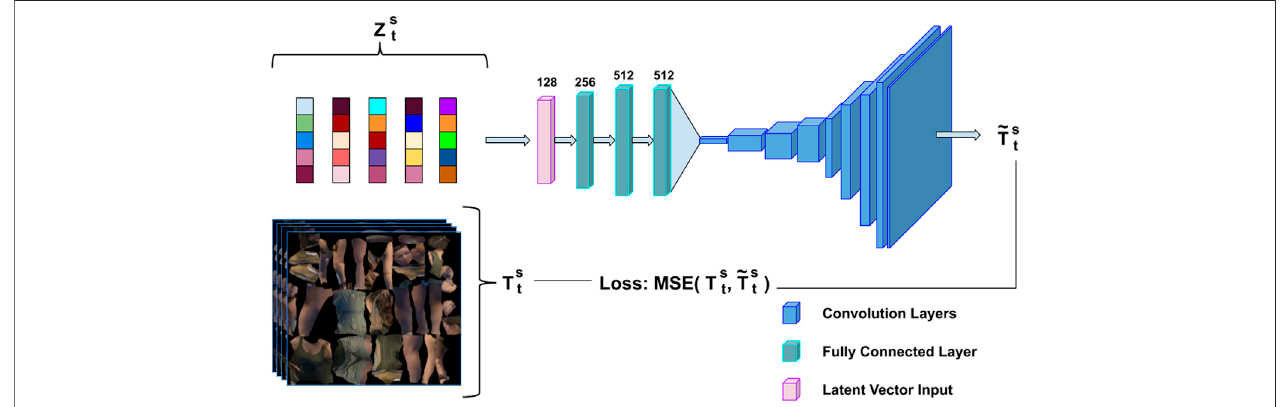
FIGURE 3 | Progressive appearance network overview. The input is learnt latent vectors from 3D skeletal motion, and the output is a high-resolution 2D texture appearance.